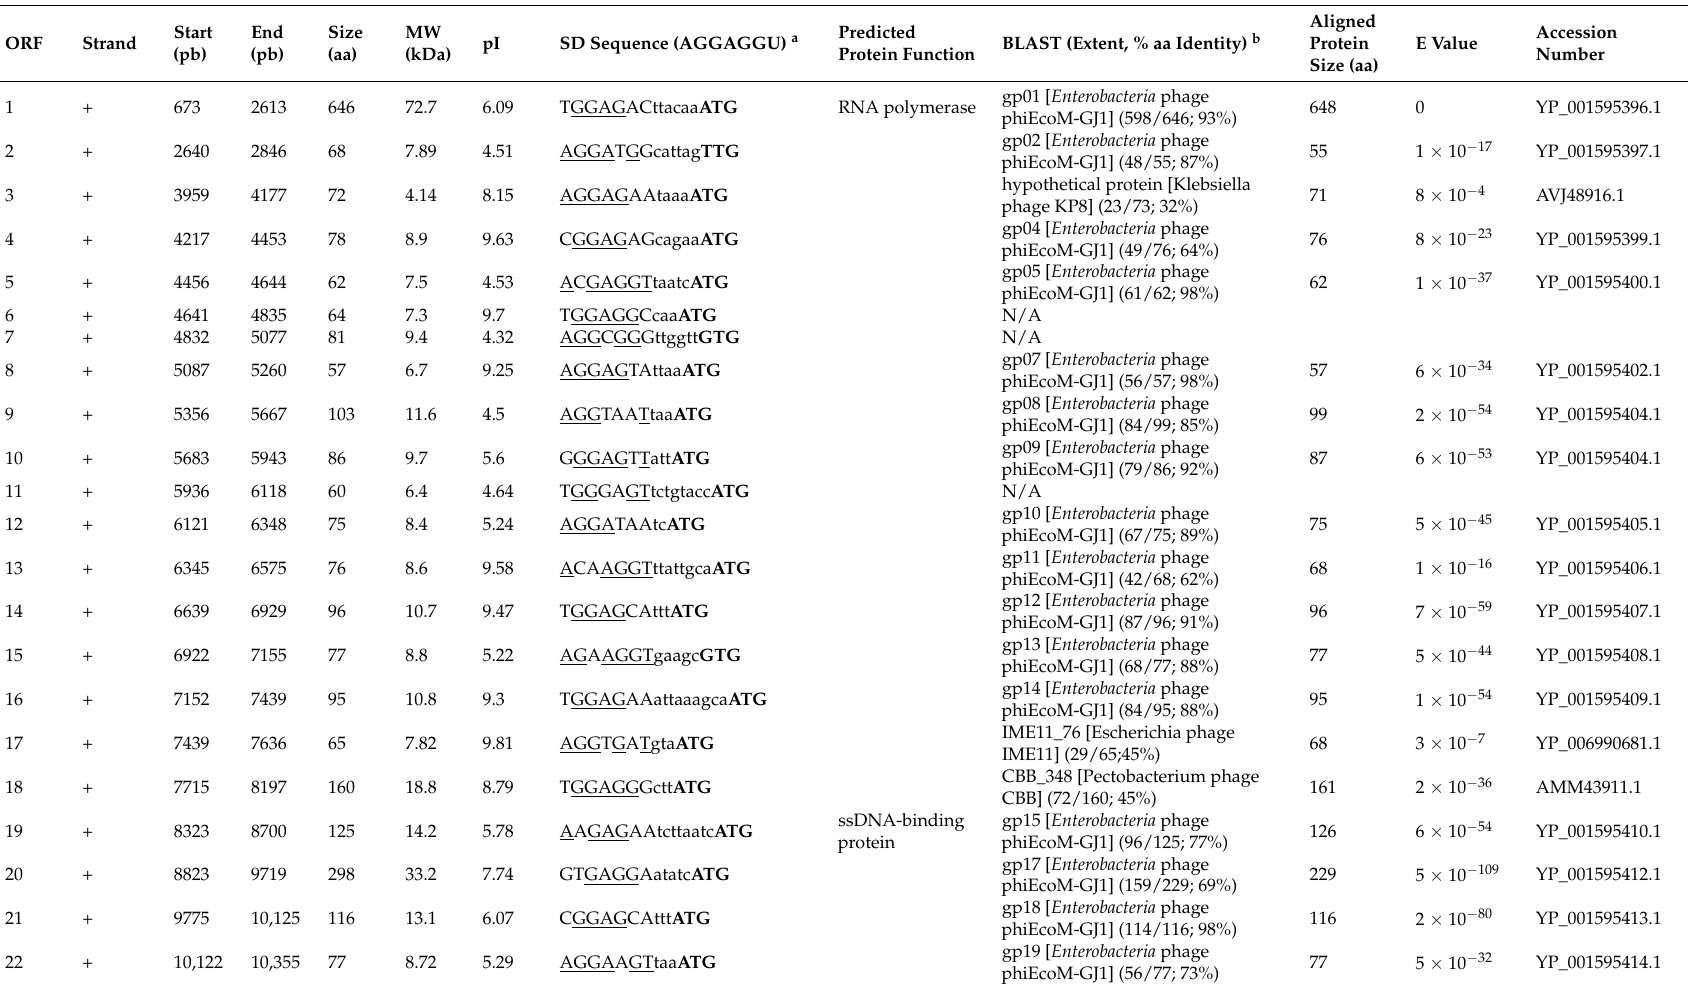
Table 2. Features of the open reading frames (ORFs) of phage